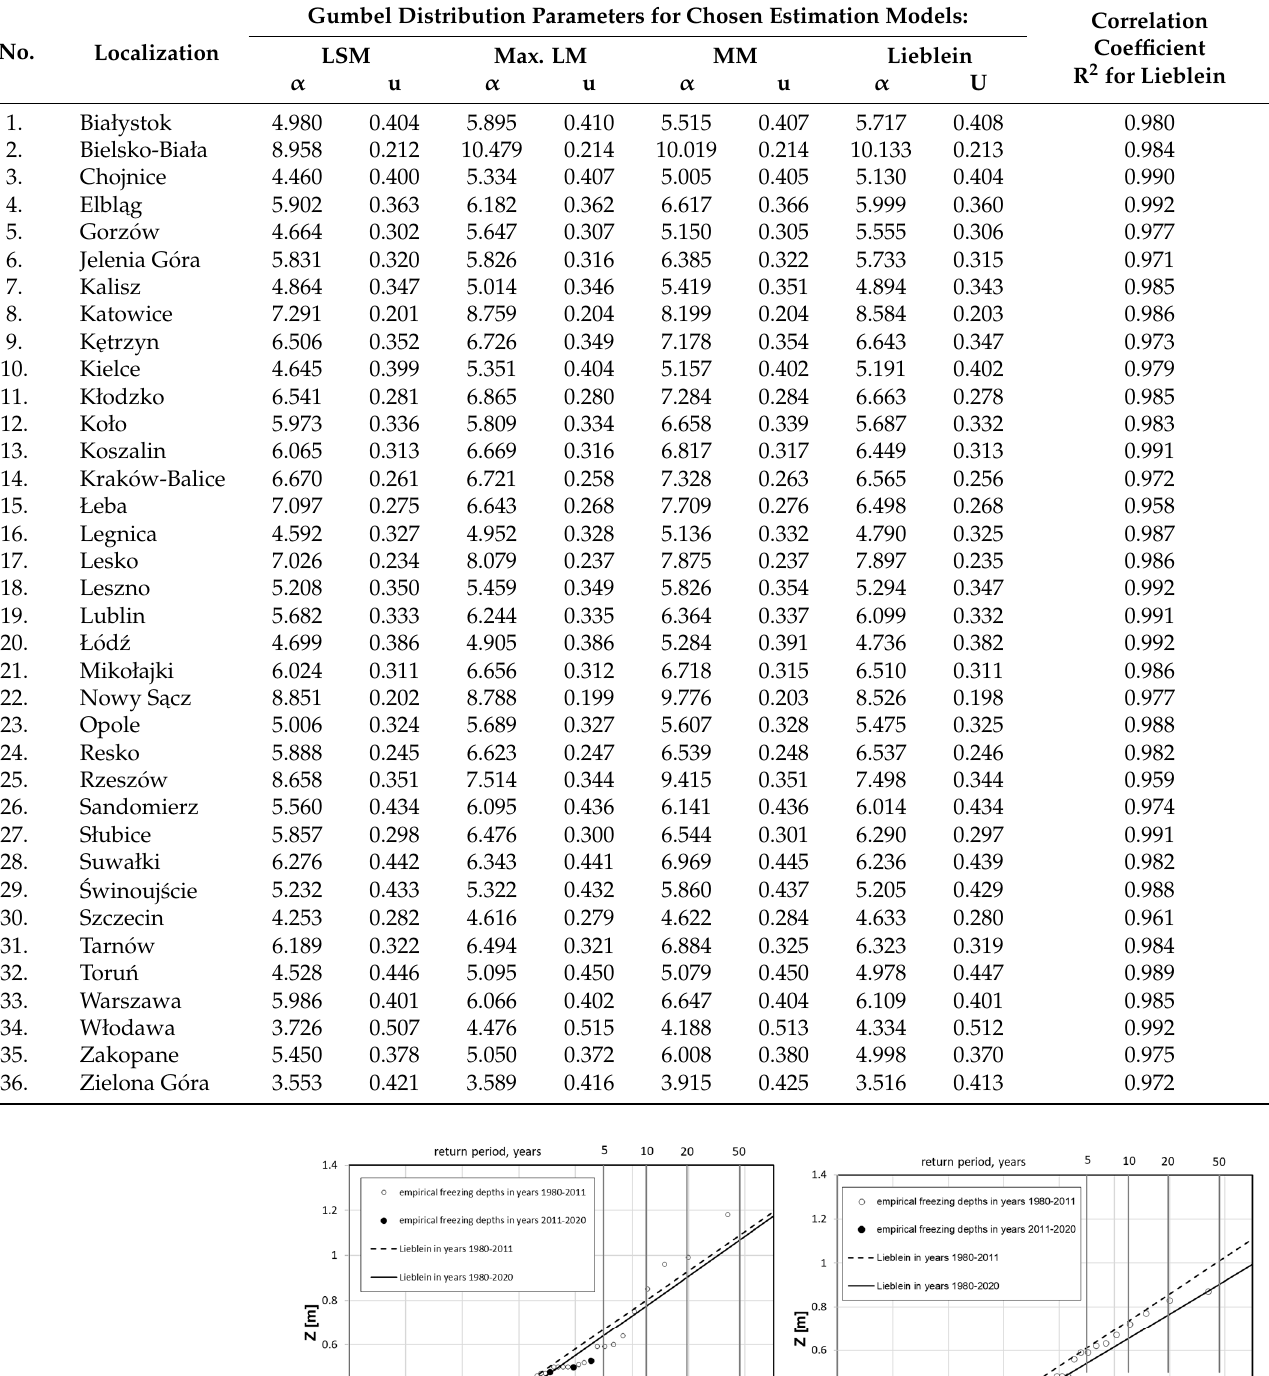
Table 1. Results of calculation for all localizations.